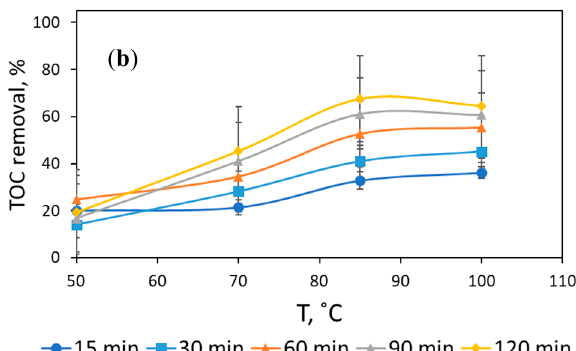
Figure 1. TOC removal at different reaction times depending on the temperature, adding ( a ) 100 mM NaNO 2 and ( b ) 50 mM NaNO 2 , and using 0.86 M HNO 3 .